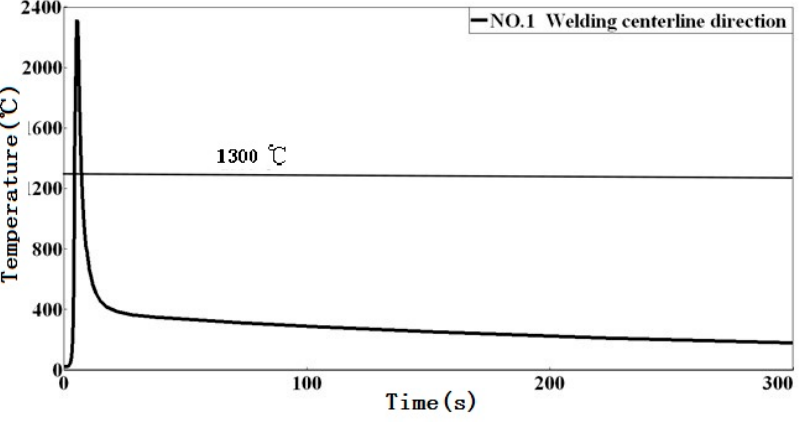
Figure 12. The temperature cycle at the midpoint of the centerline of the surfacing layer.